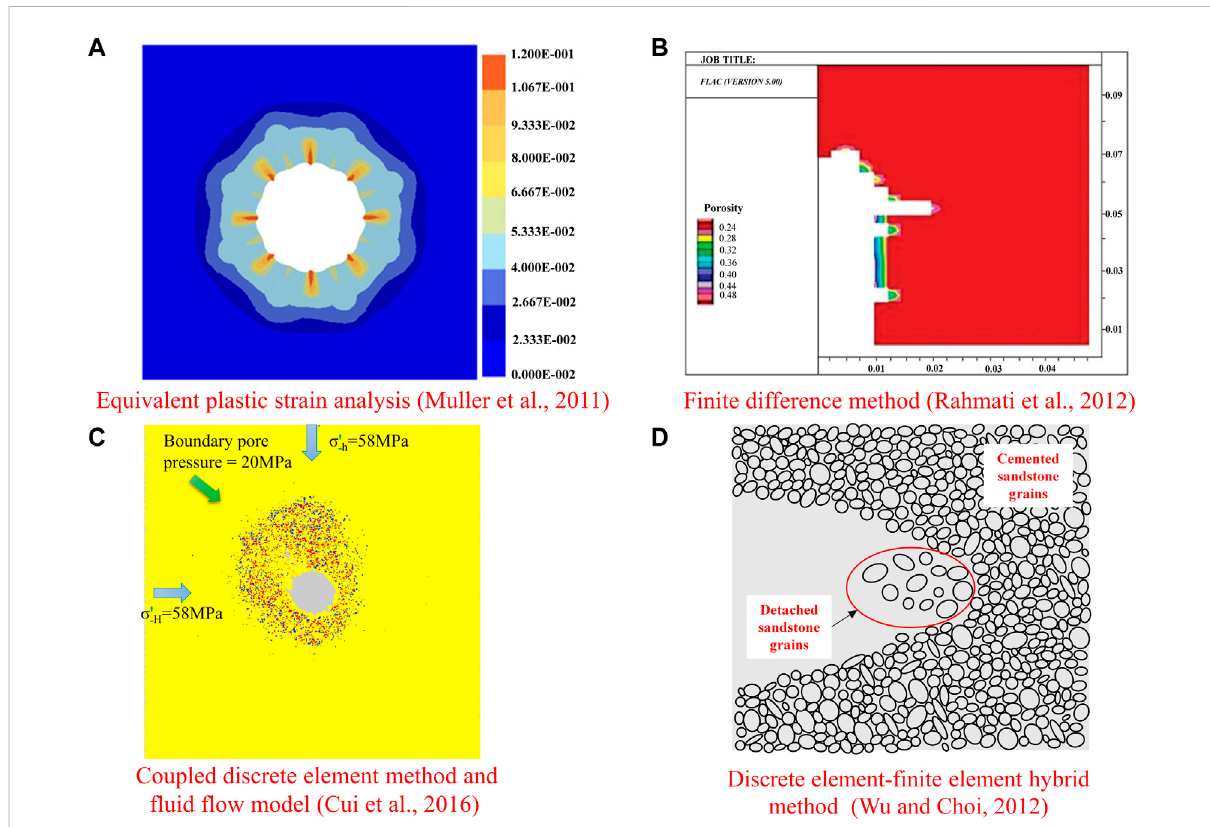
Numerical simulation methods for sand production prediction of unconsolidated sandstone. (A) corresponds to the numerical simulation results of equivalent plastic strain analysis, (B) corresponds to the numerical simulation results of fi nite difference method, (C) corresponds to the coupled discrete element method and fl uid fl ow model, and (D) corresponds to the discrete element- fi nite element hybrid